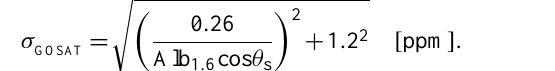
Fig. 3. Normalized vertical weighting functions for the satellite instruments considered in this study. The OCO weighting function is used for GOSAT too.